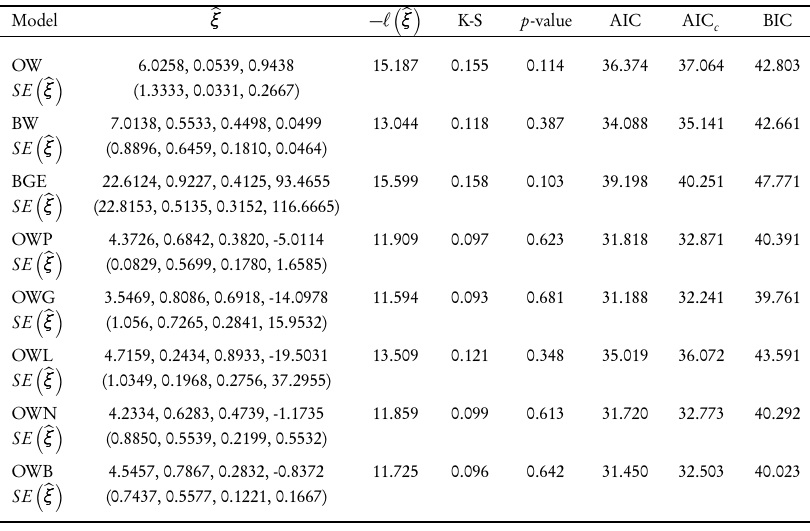
Estimates and goodness-of-fit measures for the first data set.